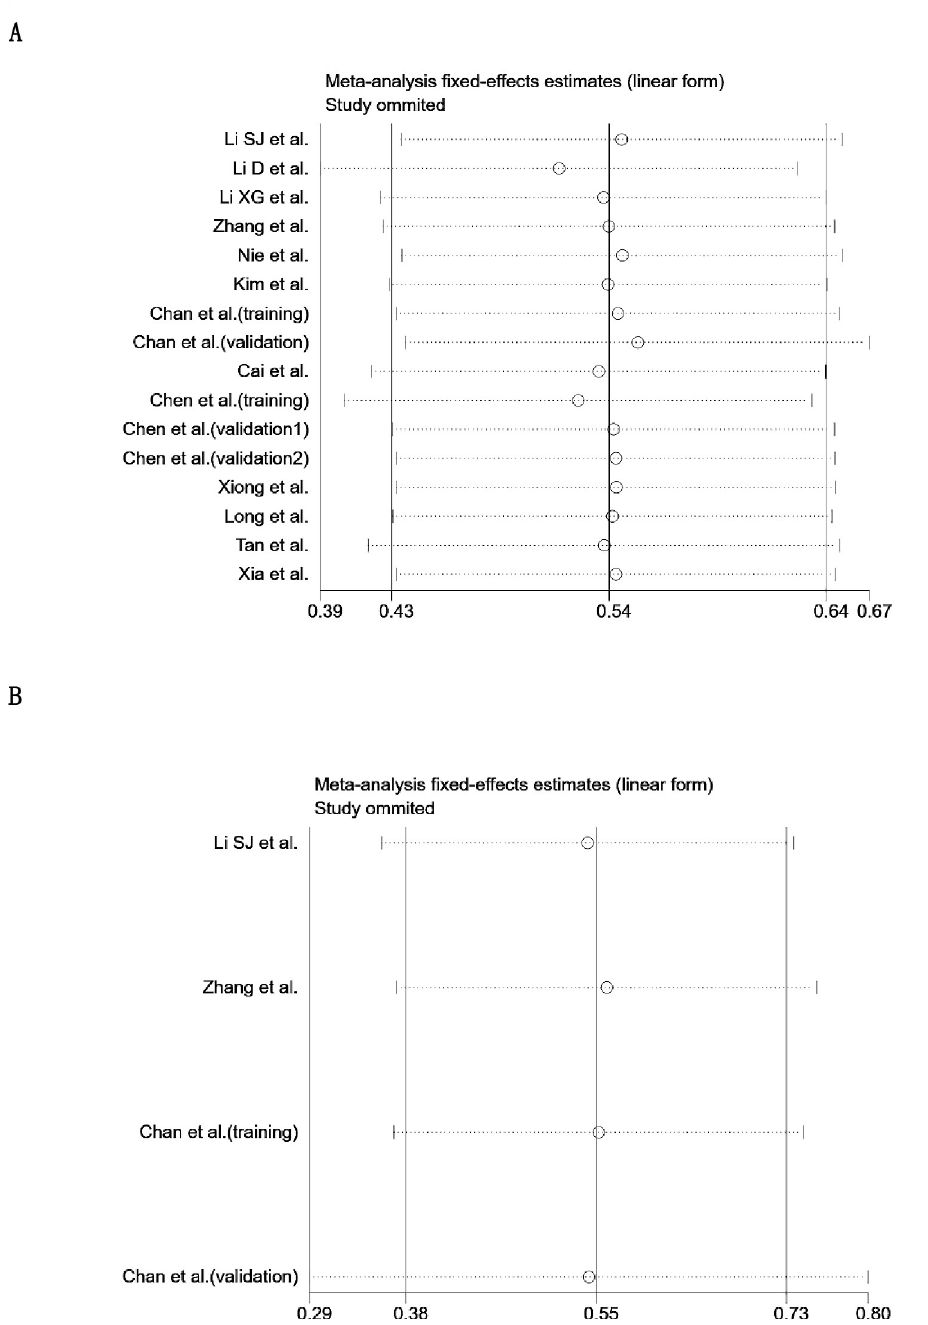
Fig 5. Sensitivity analysis of our meta-analysis. A. overall survival B. disease free